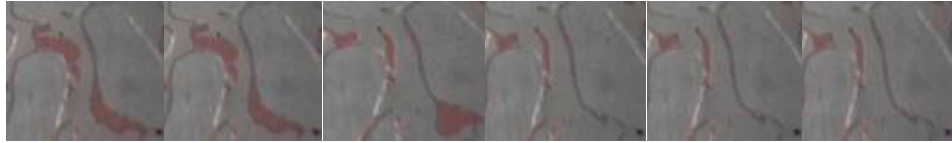
Figure 14. Variation of oil film remaining oil in the same area with different displacement rates (the time from left to right was 729, 1160, 1500, 1990, 2300, and 2633 s). At the end of the displacement rate of 0.1 mL/min (i.e., the cumulative PV number is 11.2), the significant initial drop-like remaining oil is swept and displaced into a small drop-like remaining oil. The displacement effect is noticeable. At the end of the displace- ment rate of 0.2 mL/min (i.e., the cumulative PV number is 20.7), it can be seen that the location of the drop-like remaining oil is unchanged. This shows that the displacement efficiency cannot be improved by changing the displacement rate. When the displacement rate is 0.3 mL/min (i.e., the cumulative injected PV number is 39.2), a small number of residual oil drops are displaced. However, it can be seen that the position of many small residual oil drops changes, indicating that these residual oil drops are displaced. When the displacement rate is increased to 0.4 mL/min (i.e., when the cumulative injected PV number is 56.6), most of the remaining oil drops are displaced, leaving only a few drops. When the displacement rate increases to 0.5 mL/min (i.e., when the cumulative injected PV number is 80.0), the displacement effect does not increase significantly (see Figure 15). When the water injection rate increases from 0.05 to 0.5 mL/min, the area of residual oil in drops decreases from 0.220 to 0.036 mm 2 . The oil displacement efficiency was increased by 83.81%.